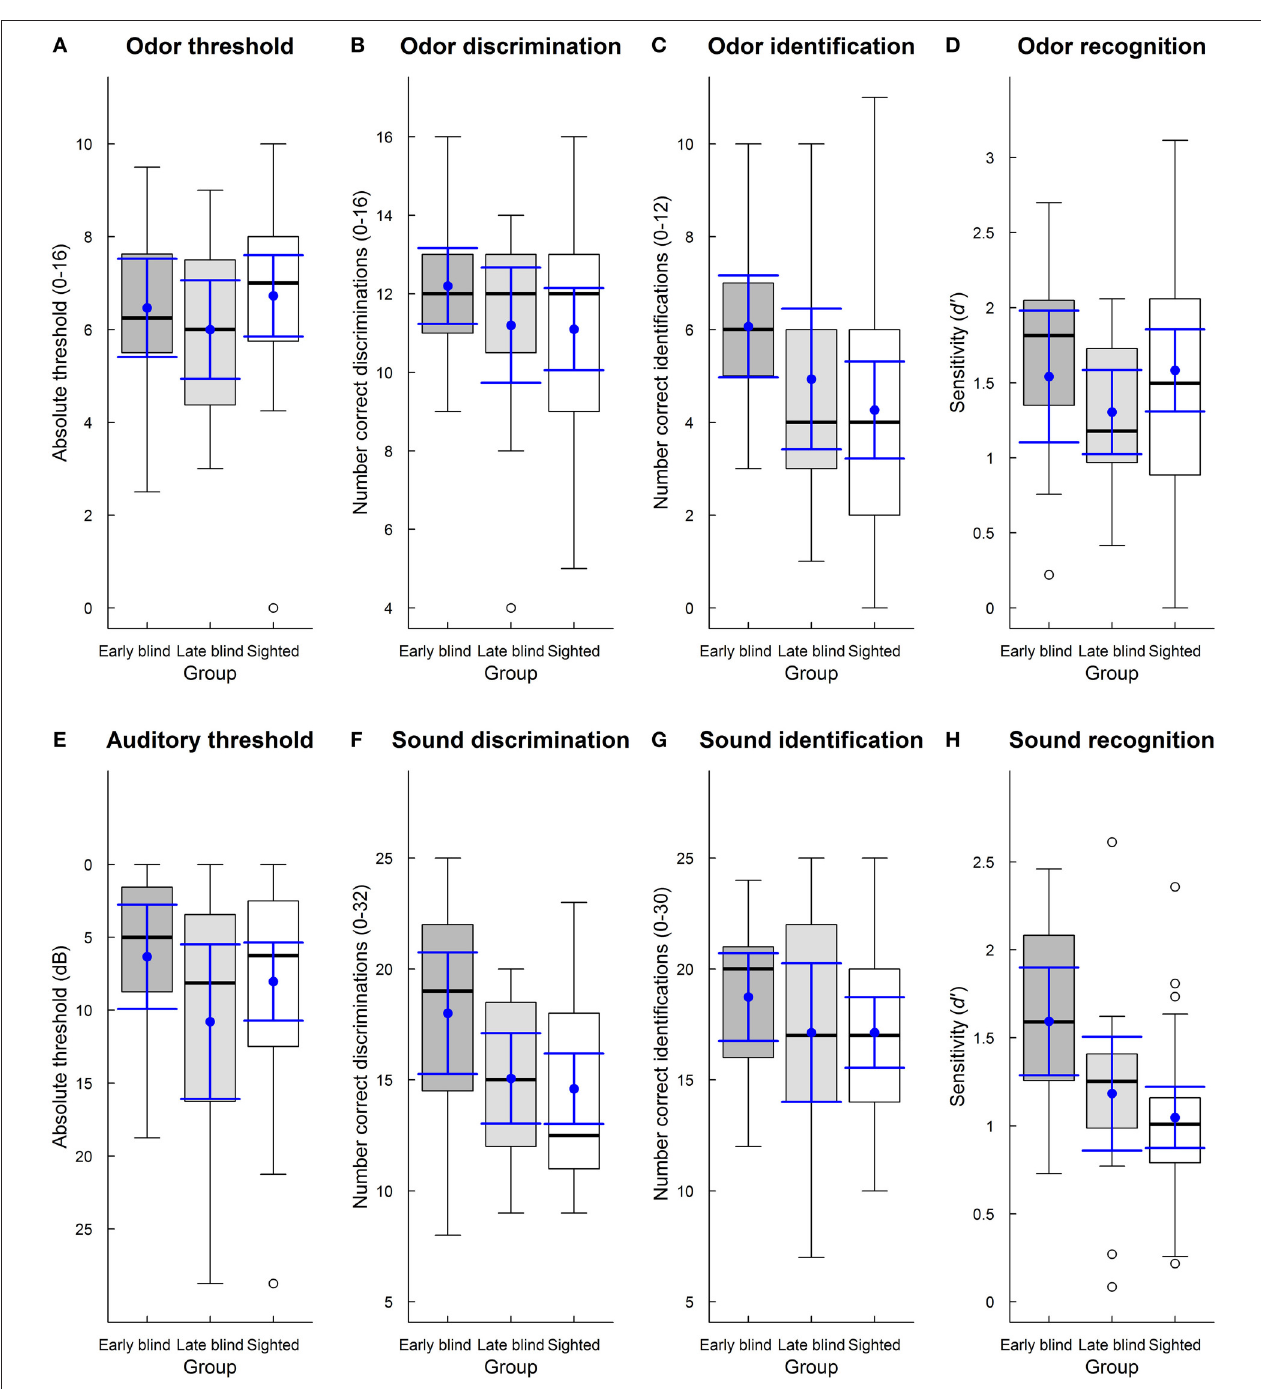
FIGURE 1 | (A–H) Boxplots of absolute odor threshold (A) , odor discrimination (B) , odor identification of high familiar stimuli (C) , episodic odor recognition ( d ’) (D) , absolute auditory threshold (E) , sound discrimination (F) , sound identification of high familiar stimuli (G) , and episodic sound recognition ( d ’) (H) . Boxplots are displayed separately for early blind (dark gray boxes), late blind (light gray boxes), and sighted (white boxes) participants. The boxes indicate the 25th, 50th (median), and 75th percentiles of the distribution (lower, middle, and upper horizontal lines of the box). The upper hinges indicate the maximum value of the variable located within a distance of 1.5 times the inter-quartile range above the 75th percentile. The lower hinges indicate the corresponding distance to the 25th percentile value. Circles indicate values outside these hinges (outliers). The means and 95% confidence intervals (dots and error bars in blue) are superimposed on the